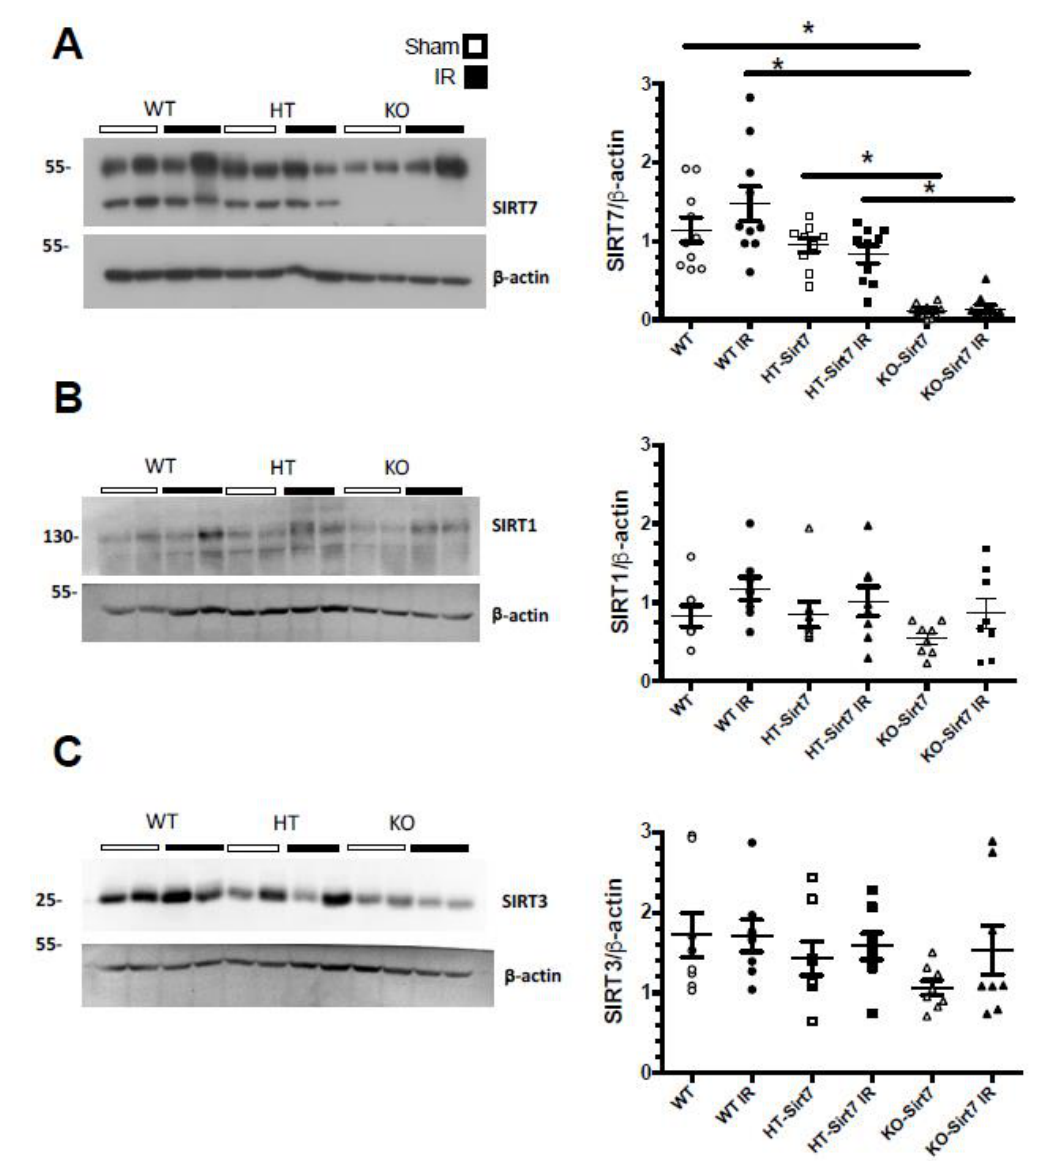
Figure 4. Sirt7, Sirt1 and Sirt3 renal expression. ( A ) Sirt7 protein levels ( B ) Sirt1 protein levels, ( C ) Sirt3 protein levels. White circles represented WT, Black circles, WT+IR, White squares, HT-Sirt7, Black squares, HT-Sirt7+IR, White triangles, KO-Sirt7, and Black triangles, KO-Sirt7+IR. n = 5–10 per group. * p < 0.05 vs. respective group marked.